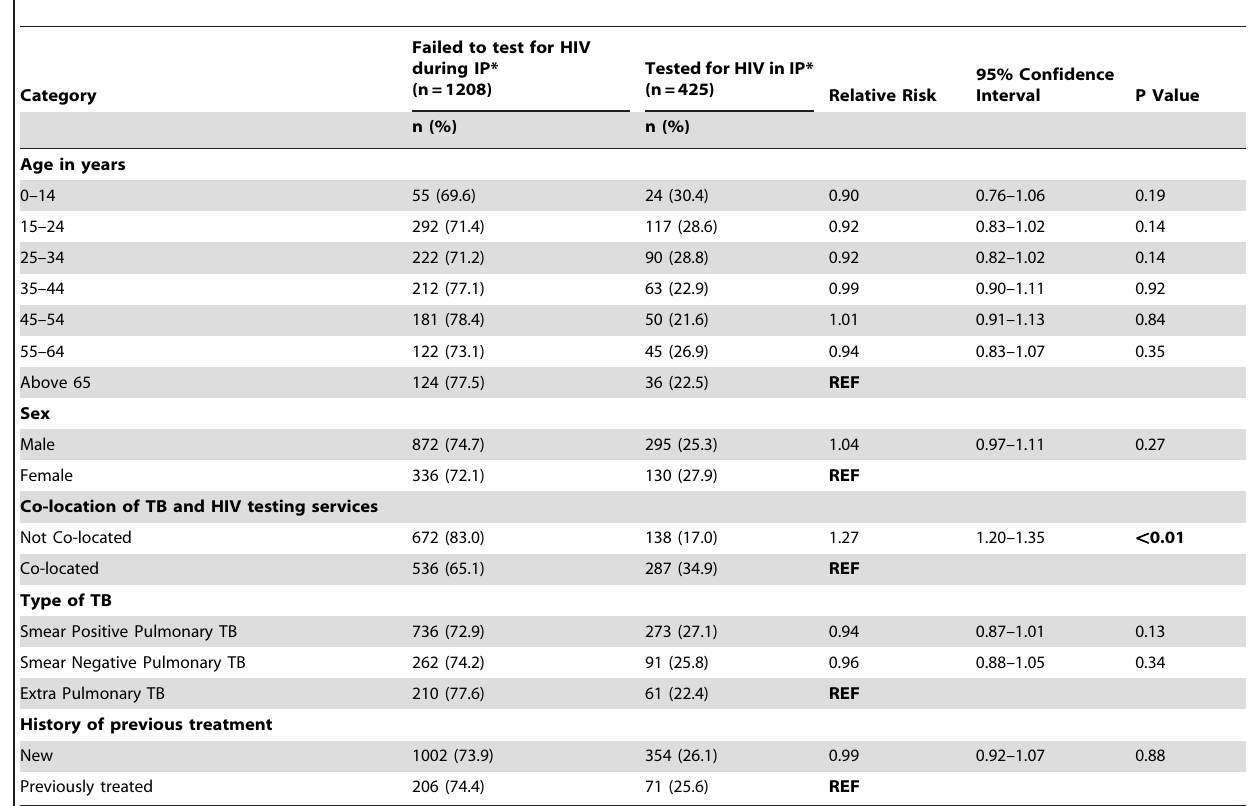
Table 2. Factors associated with failure to test for HIV among patients with TB in South 24 Parganas District, West Bengal